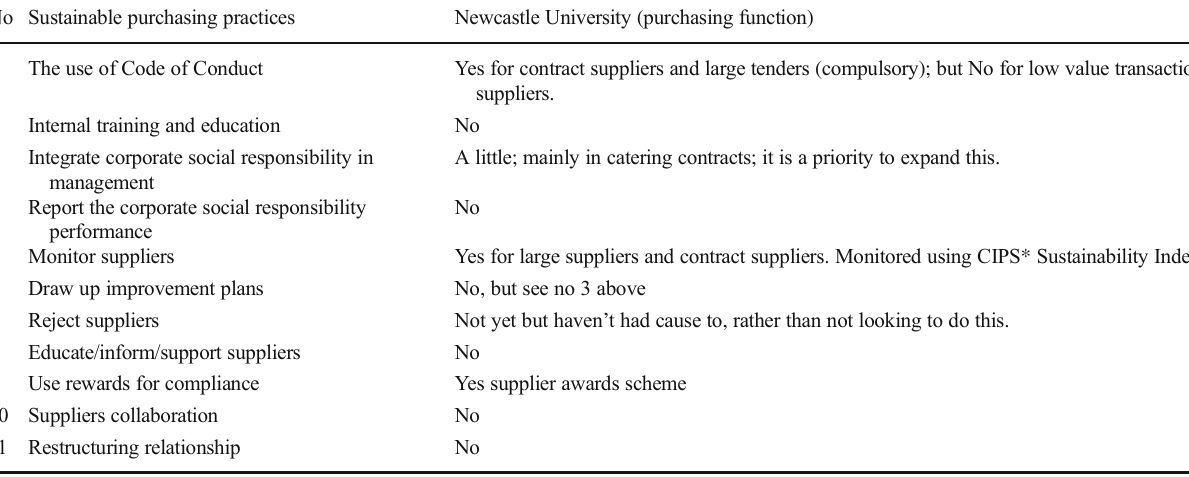
Sustainability purchasing practices in the Newcastle University purchasing function, applying the benchmark tool by Björklund [11] (source: this study) No Sustainable purchasing practices